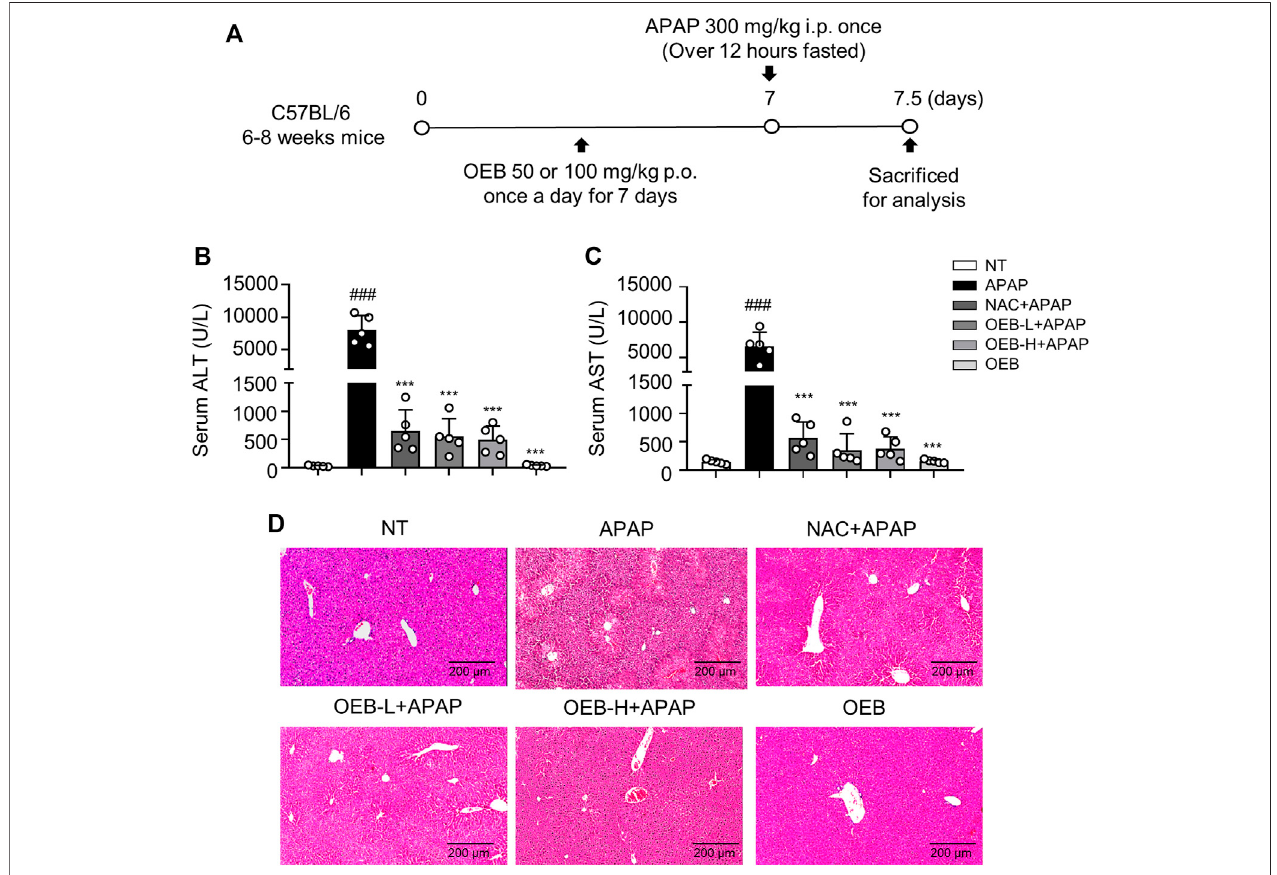
FIGURE1| Protectiveeffect ofOEBinAPAP-inducedhepatotoxicity invivo . (A) Mice werepretreatedwith50 mg/kgOEBbyintragastricadministration for7 days andadministeredasingledoseof300 mg/kgAPAPbyintraperitonealinjectionandeuthanizedafter12 h.Hepatotoxicitywasanalyzedbymeasuringserum (B) ALTand (C) AST levels ( n = 5). (D) Hematoxylin and eosin-stained liver sections. *** p < 0.001 versus APAP-treated group, ### p < 0.001 versus NT